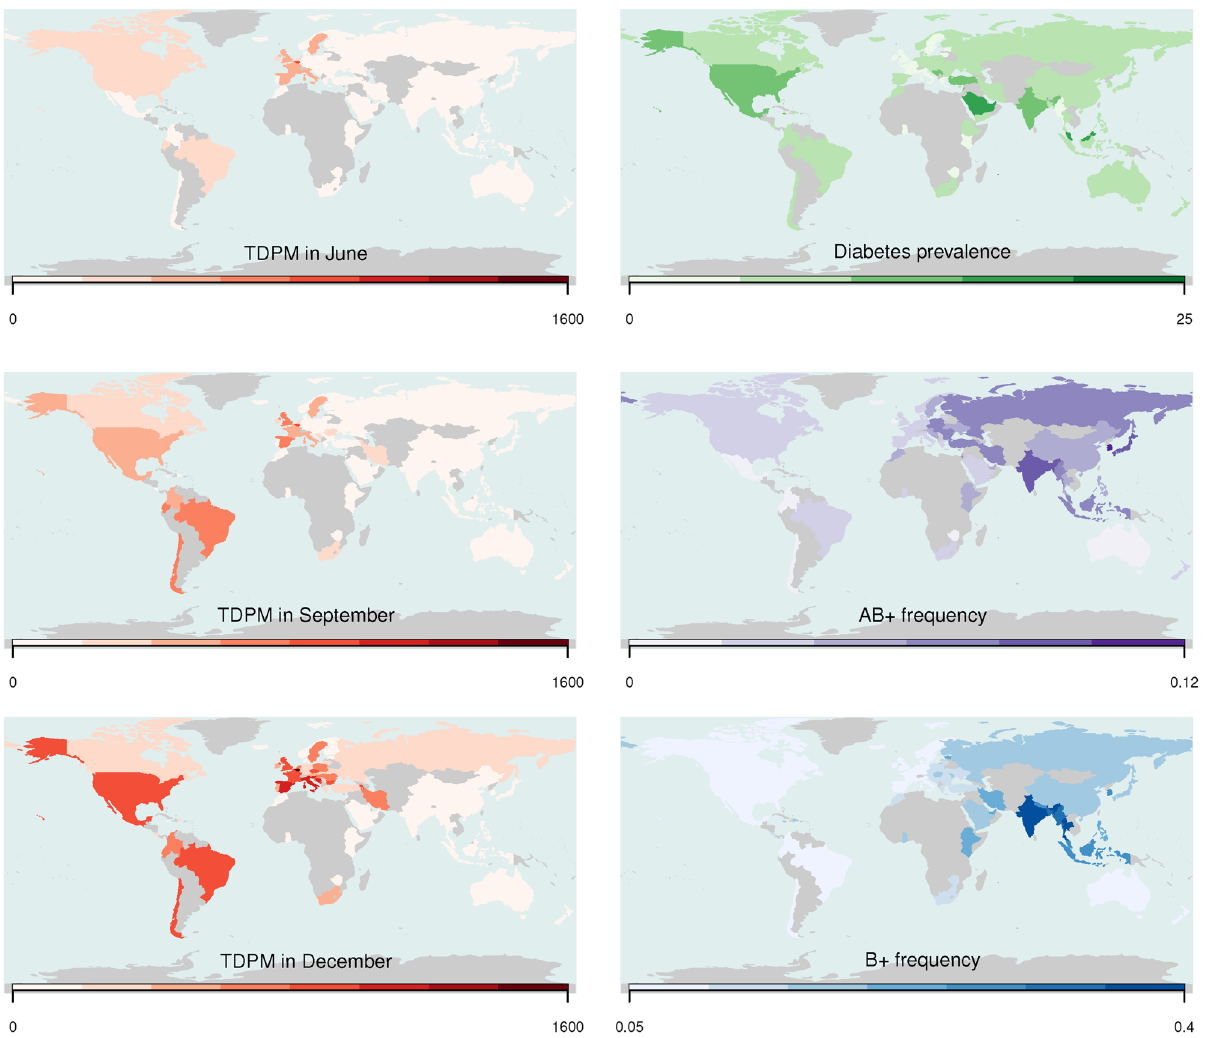
Figure 5. Map of the TDPM in June, September, and December 2020 on the left. Maps of some of the input features on the right. Countries not included in the analysis are colored in gray. R package Rworldmap 1.36 was used to generate the